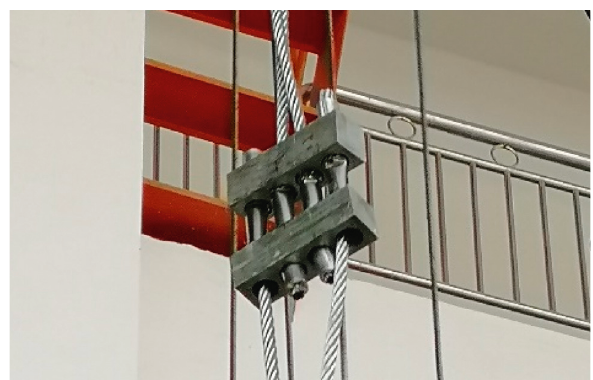
Figure 17: Symmetric tube-crushing dissipators after dynamic impact.